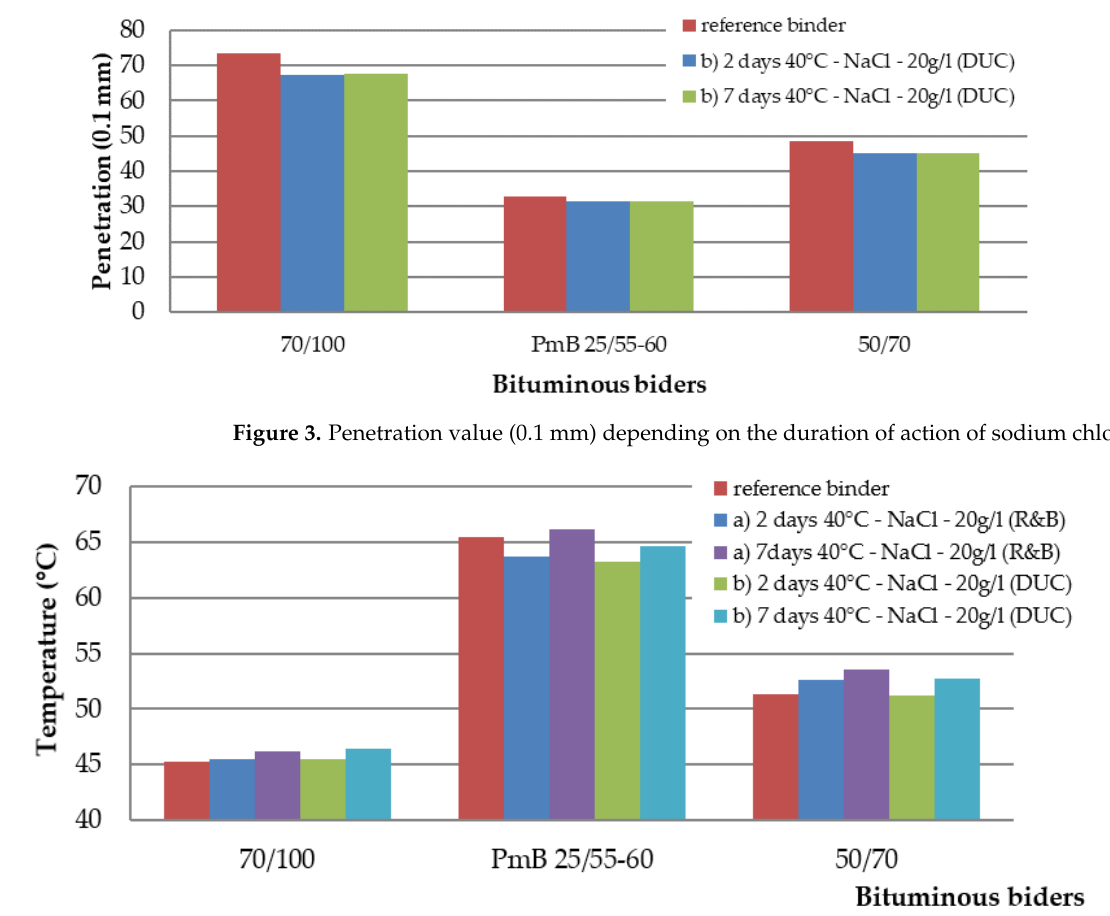
Figure 4. Softening point (°C) depending on the duration of action of sodium chloride.